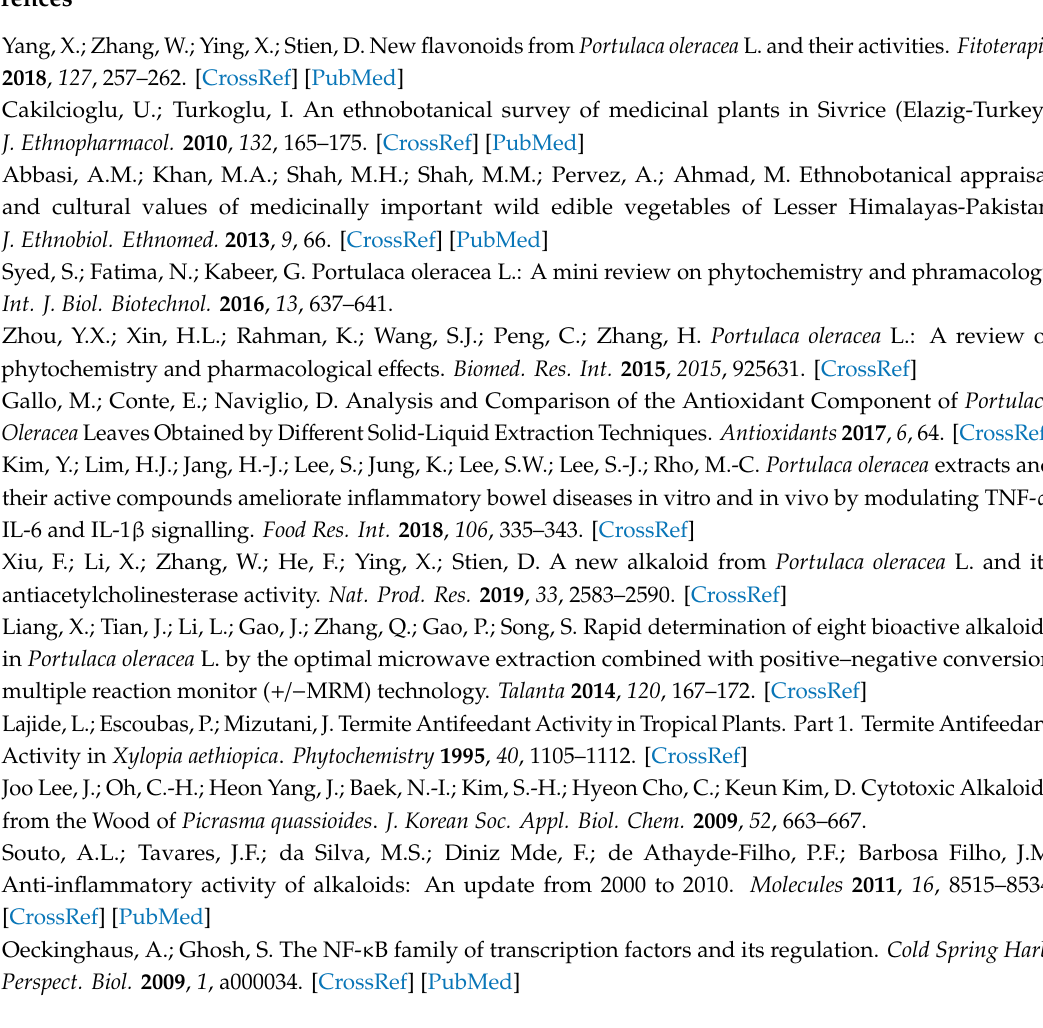
Figure S1: HRESIMS spectrum of compound 8 . Figure S2: IR spectrum of compound 8 . Figure S3: 1 H NMR (600 MHz, methanol- d 4) spectrum of compound 8 . Figure S4: 13 C NMR (150 MHz, methanol- d 4) spectrum of compound 8 . Figure S5: COSY (600 MHz, methanol- d 4) spectrum of compound 8 . Figure S6: HMQC (600 MHz, methanol- d 4) spectrum of compound 8 . Figure S7: HMBC (600 MHz, methanol- d 4) spectrum of compound 8 . Figure S8: 1 H NMR (600 MHz, methanol- d 4) spectrum of compound 15 . Figure S9: 13 C NMR (150 MHz, methanol- d 4) spectrum of compound 15 . Figure S10: COSY (600 MHz, methanol- d 4) spectrum of compound 15. Figure S11: HMQC (600 MHz, methanol- d 4) spectrum of compound 15 . Figure S12: HMBC (600 MHz, methanol- d 4) spectrum of compound 15 . Figure S13: 1 H NMR (600 MHz, methanol- d 4) spectrum of compound 20 . Figure S14: 13 C NMR (150 MHz, methanol- d 4) spectrum of compound 20 . Author Contributions: E.-J.P. and H.-J.J. performed the general experiments which were isolation and elucidation of chemical structures. K.-H.K., S.-J.L., and C.S.P. carried out the biological experiments. H.-J.J., B.-S.Y.,